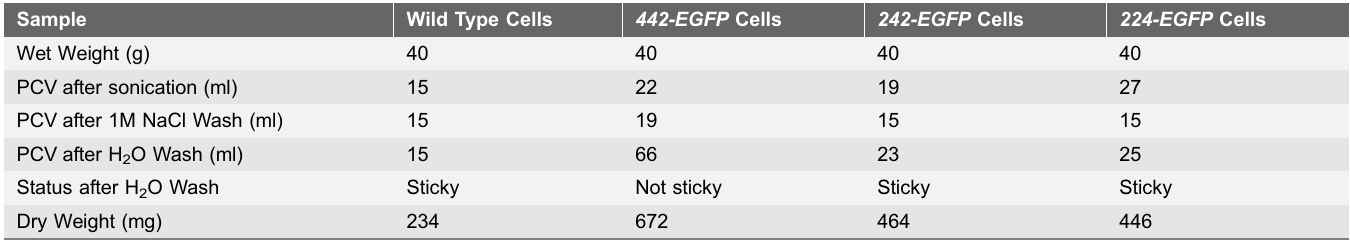
Table 3. Packed cell wall volume (PCV) of each cell line during cell wall